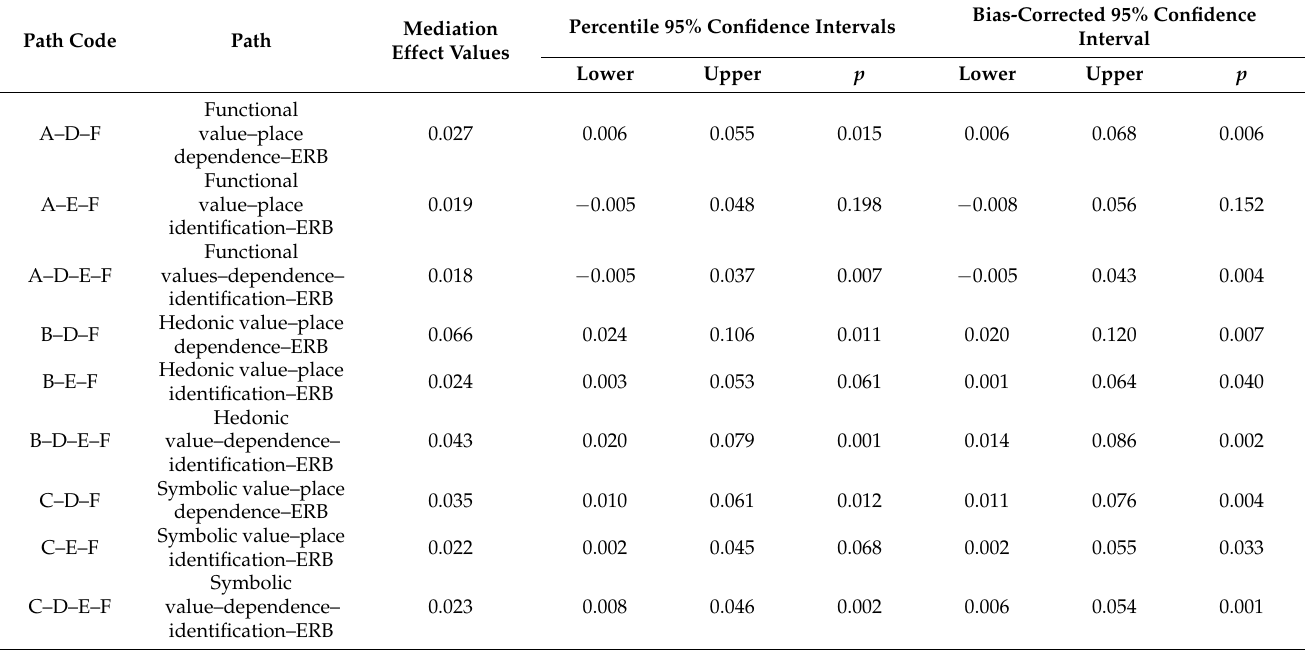
Table 7. Analysis of the mediating effect of place